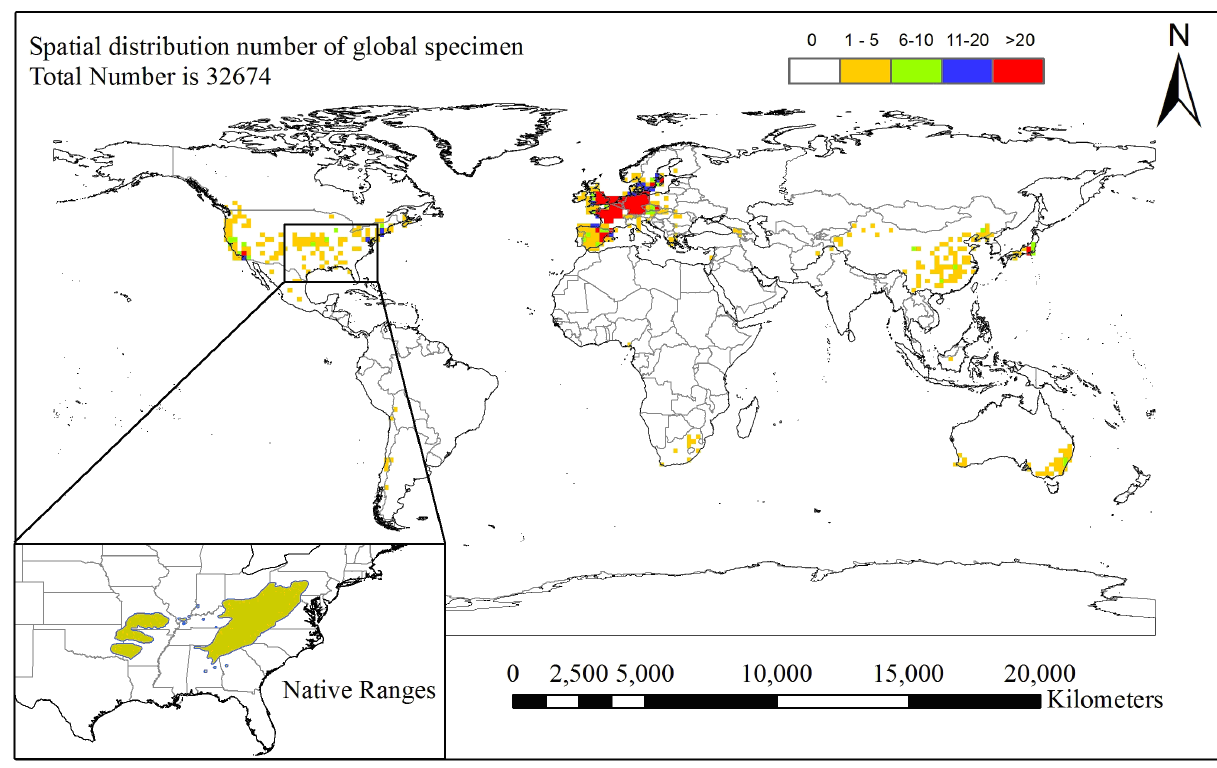
Figure 1. Global spatial abundance of black locust specimens around the world (the grid cell is 1.5° × 1.5°) and its native range in eastern North America [1]; the total number of specimens is 32,674 (32,434 from Global Biodiversity Information Facility (GBIF) and 240 from Chinese Virtual Herbarium (CVH); the GBIF database query date is 9 May 2014, and the CVH database query date is 10 May